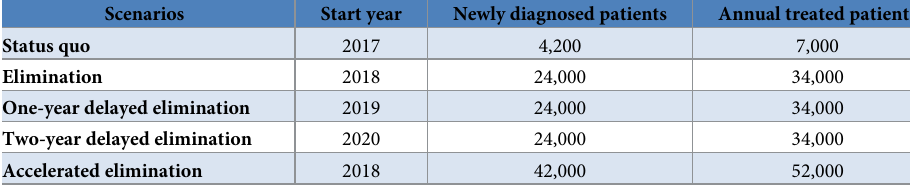
Table 2. HCV-related intervention inputs implemented annually by scenario, 2017–2030 �